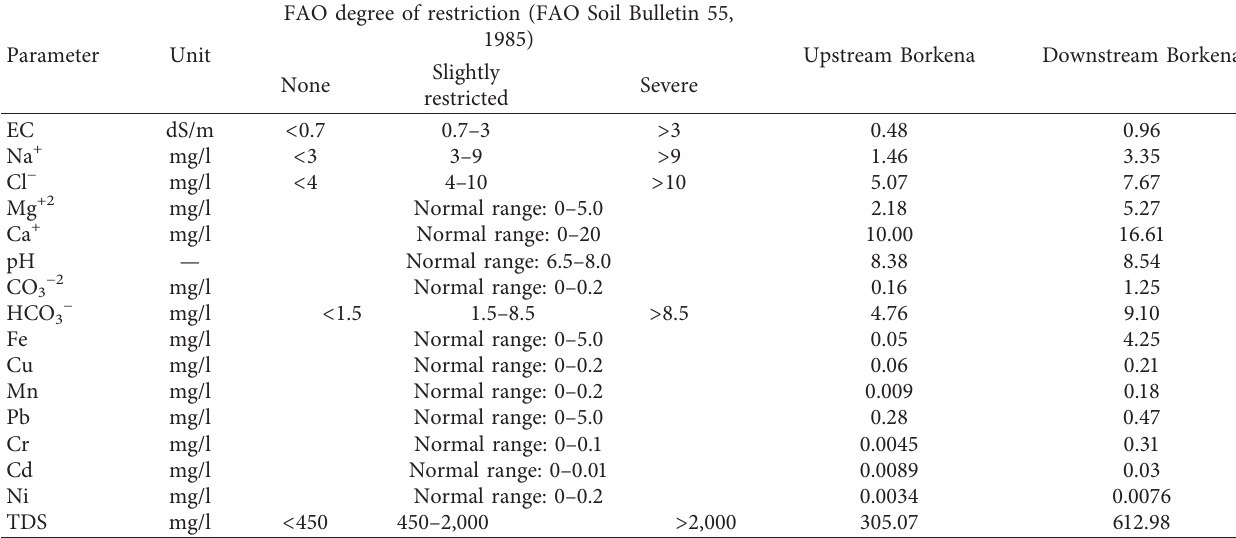
Table 4: Mean values of irrigation water characteristics compared with the degree of